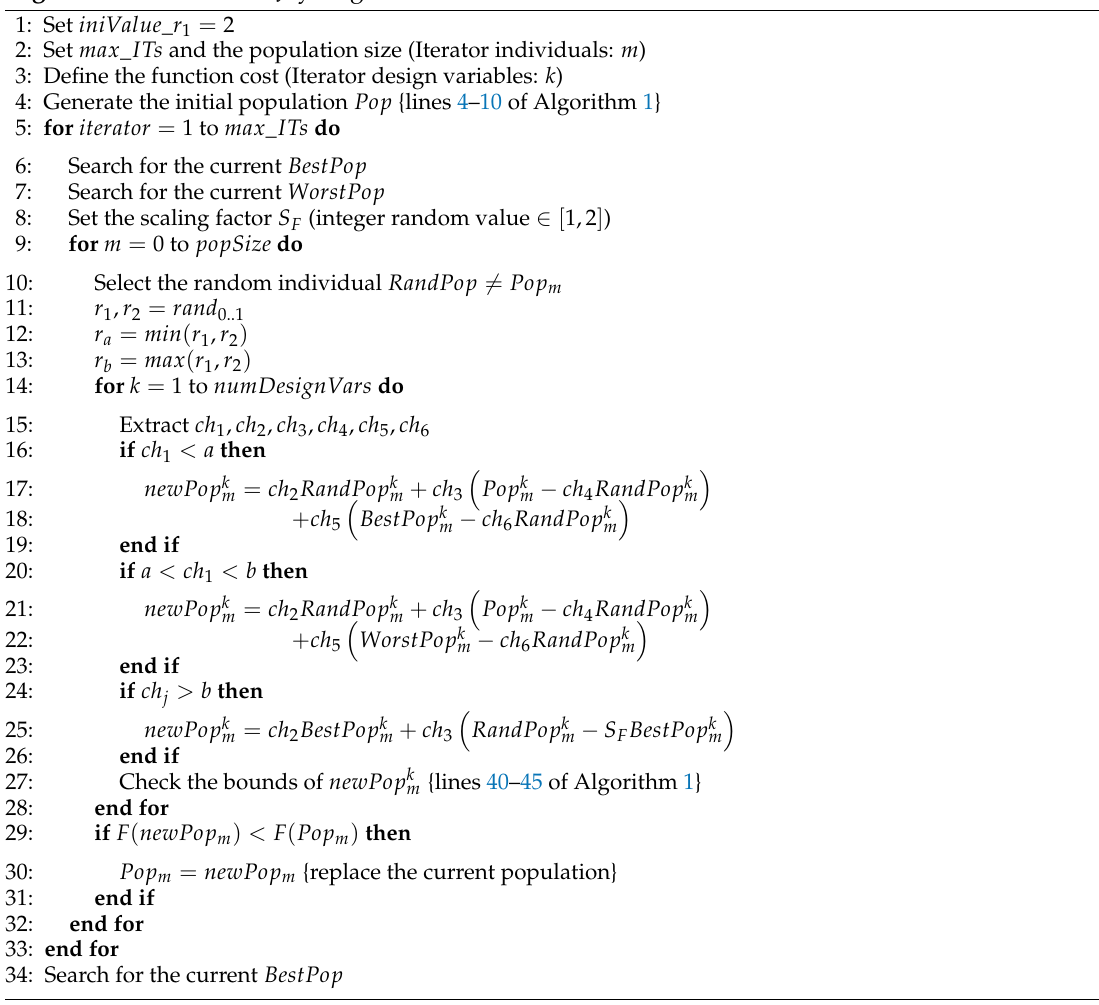
Algorithm 5 Chaotic 2D Jaya